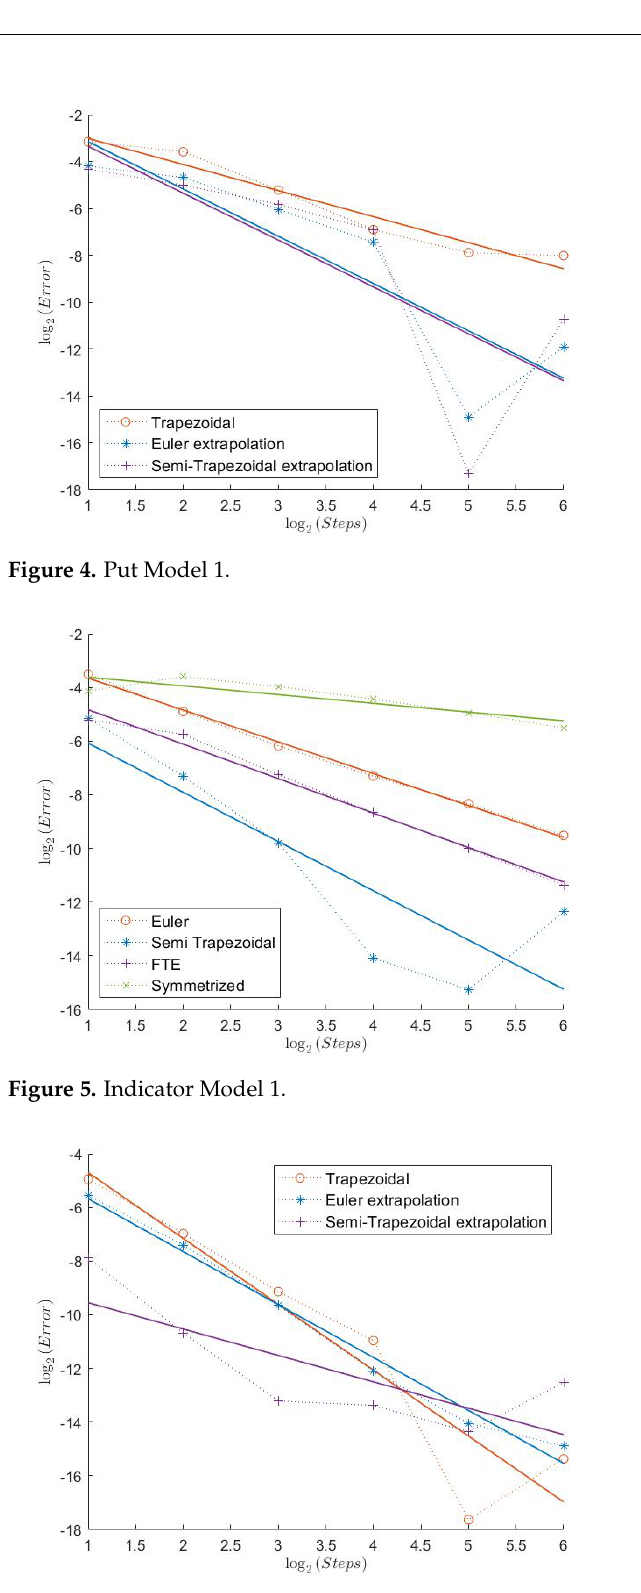
Figure 6. Indicator Model